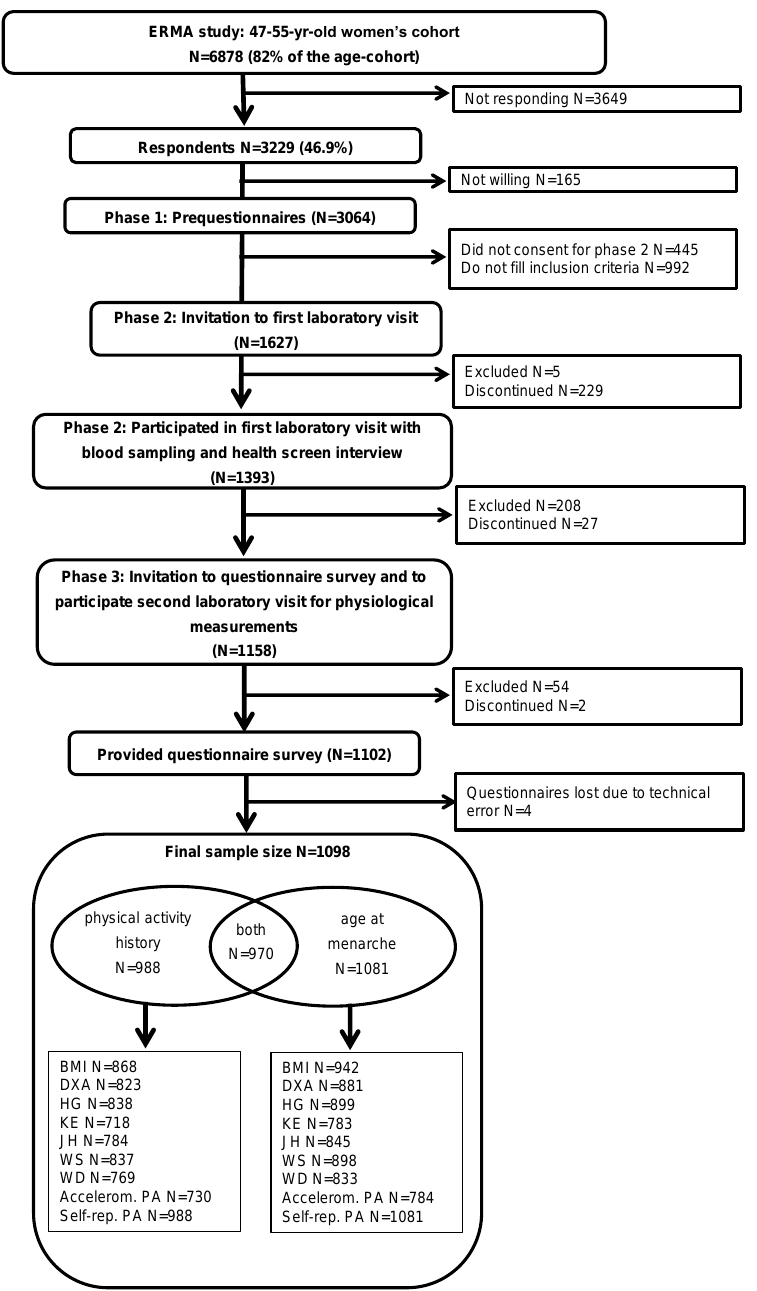
Figure 1. Flow chart of the recruitment of the participants. BMI = body mass index; DXA = Dual-energy X-ray absorptiometry; HG = hand grip force; KE = knee extension force; JH = jumping height; WS = walking speed; WD = walking distance; accelerom. PA = accelerometer-measured physical activity; self-rep. PA = self-reported physical activity. Some of the participants were excluded for some or all physical performance tests for the health